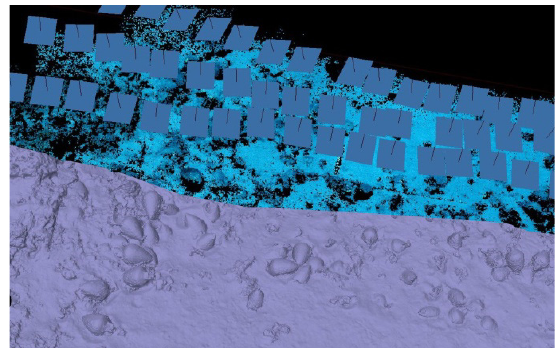
Figure 7: Detail of 3D shaded model, flight plan and point